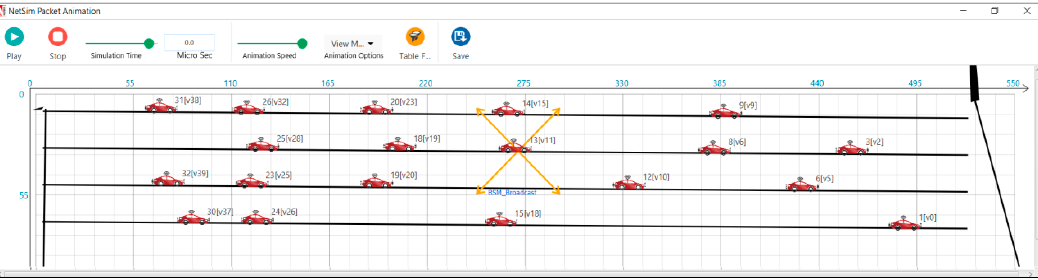
Figure 8. Clustering of vehicles in dense traffic scenario.